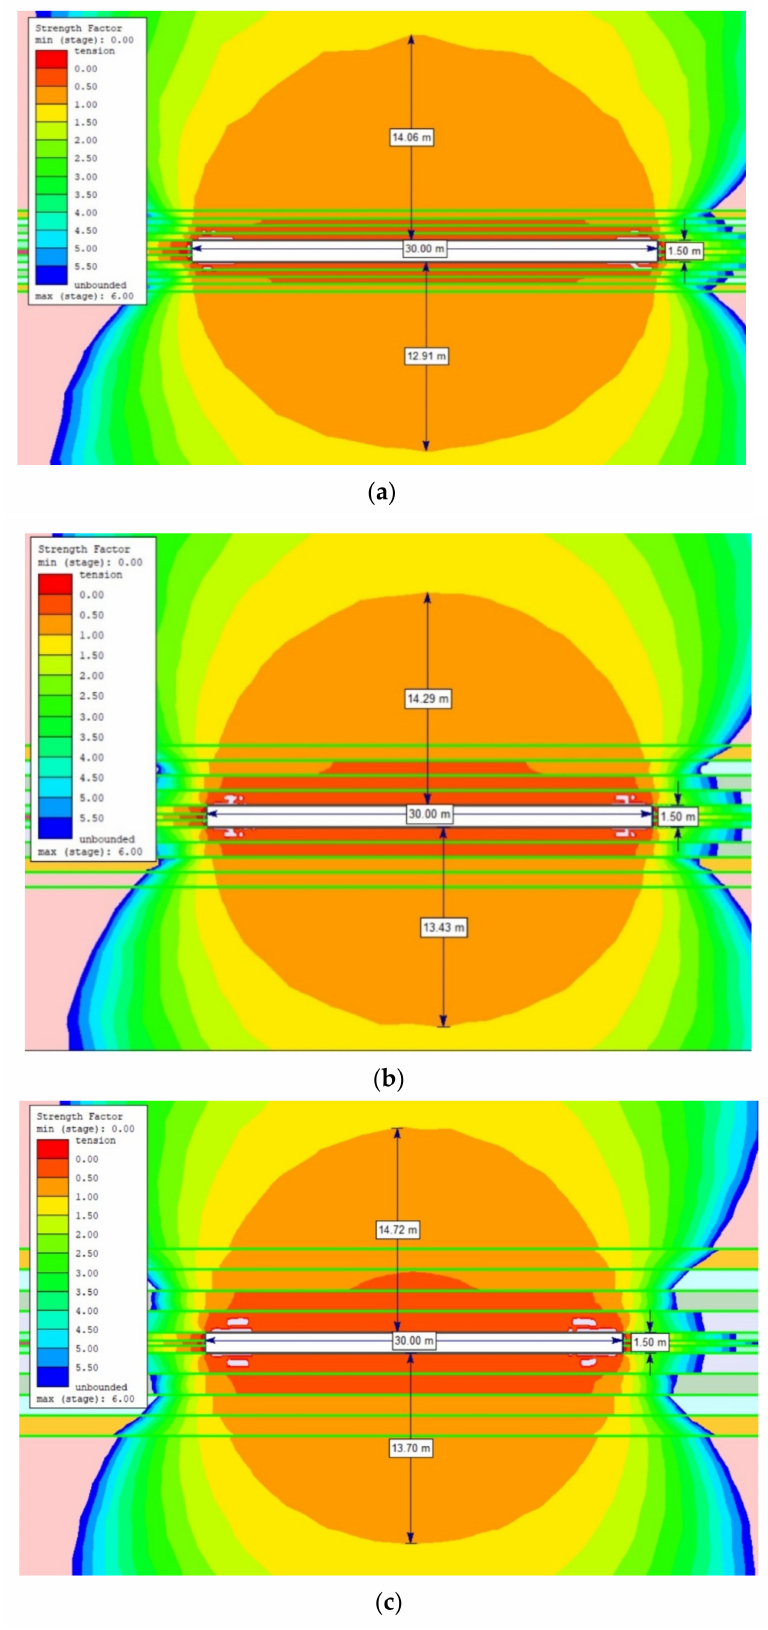
Figure 16. The extent of the rock destruction zone around the gasification channel with a width of 30 m and the impact of temperature of 1200 ◦ C for the dry rock mass, up to the height of: ( a ) 0.5 m; ( b ) 1.0 m; ( c ) 1.5